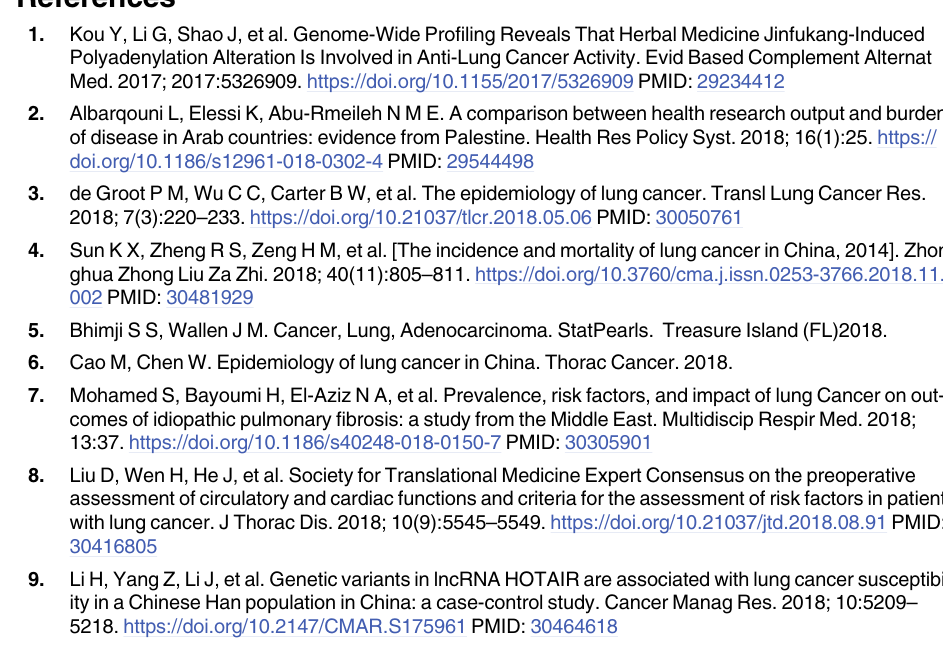
S2 Table. FPRP and statistical power values of the association analysis results in the sub- group analysis. S3 Table. Haplotype frequencies of COL6A4P2 polymorphisms and their association with the risk of lung cancer. S4 Table. Genotyping results of all